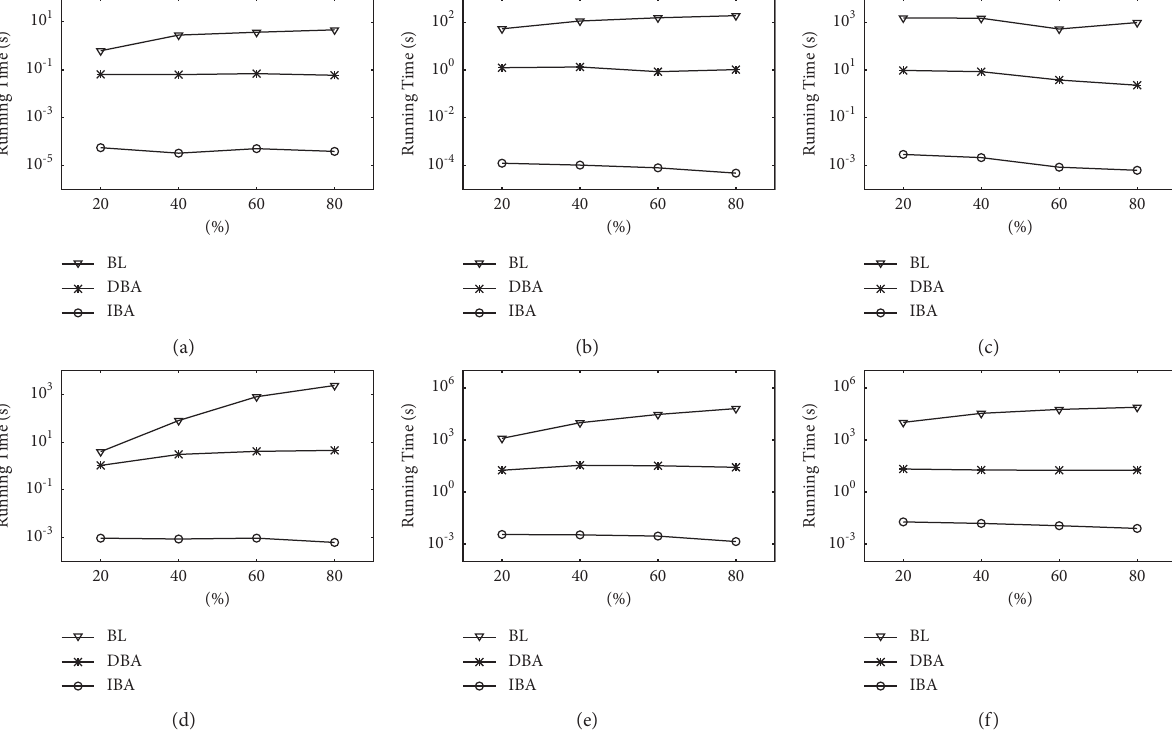
Figure 5: Experiment results by varying weight distribution ω of query vertices: (a) Email-Eu-core, (b) Facebook, (c) Email-Enron, (d) Brightkite, (e) Gowalla, and (f)